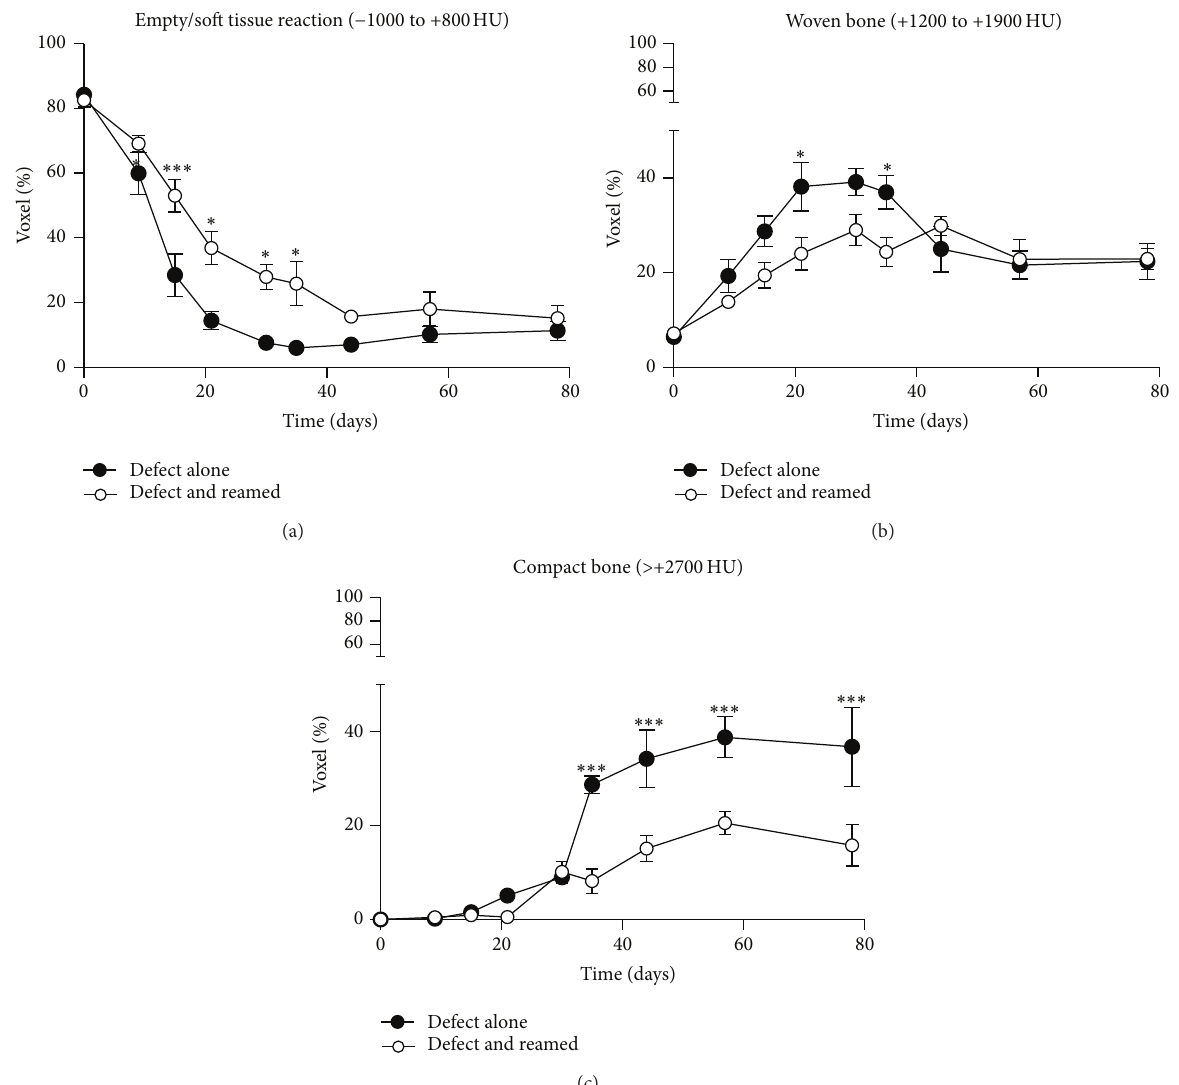
Figure 4: Bone healing as a function of time for a defect without reaming and a defect with reaming. (a) The results were quantified and plotted as a percentage of voxels representing nonorganized material as a function of time for unreamed femurs with a defect and reamed femurs with a defect. The percentages of (b) woven and (c) dense bone formation as a function of time were also graphed. The results were obtained from nine mice ( 𝑛 = 9 ; ∗ 𝑃 < 0.05 , ∗∗∗ 𝑃 < 0.0001